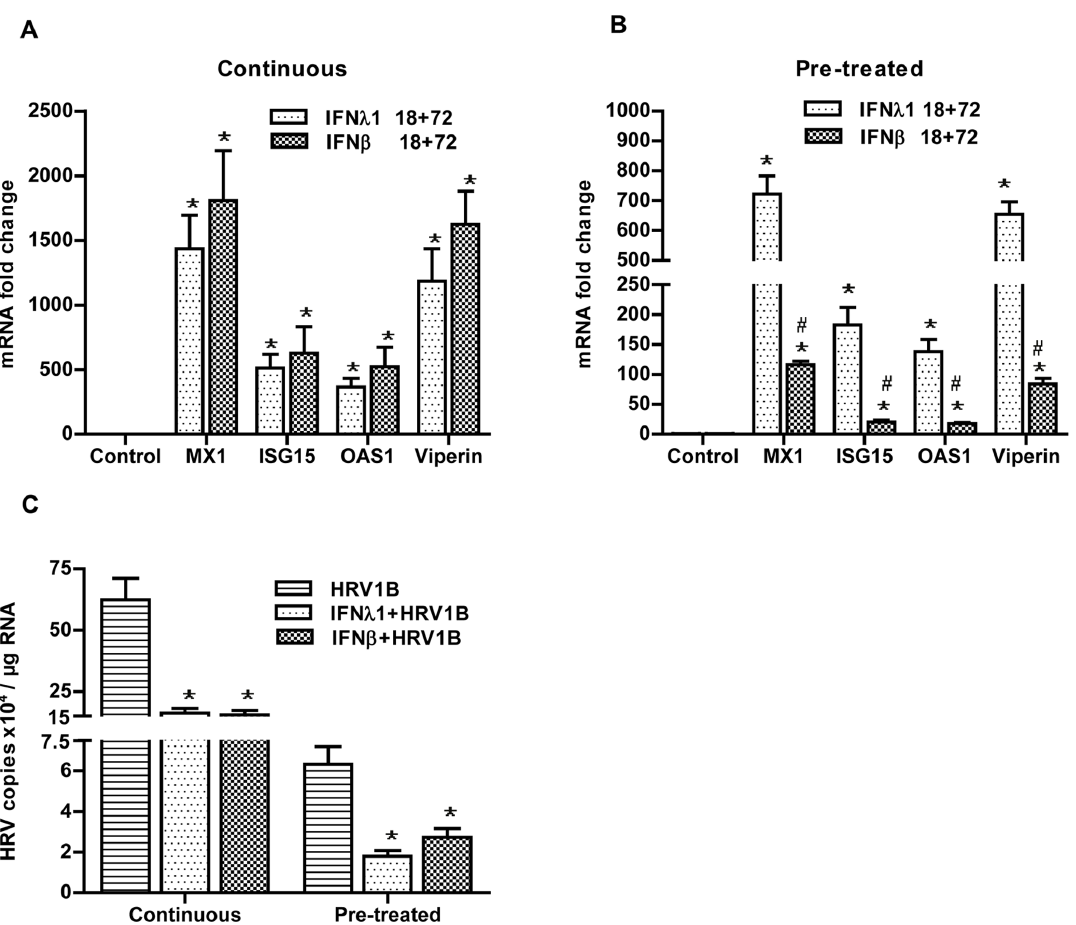
Figure 2. Long-lasting antiviral state induced by IFNs. A549 were treated with IFNs for 18 h. Next, according to the continuous and pre- treatment approaches, cells cultured for another 72 h and collected afterwards for further analyses (n=4). mRNA expression of different genes was determined by qPCR and fold changes were calculated with the 2 2 DD Ct method (A & B). Moreover, to evaluate the antiviral status of the cells after 72 h of culturing, cells were infected with HRV1B and incubated for another 24 h (n=5). After that, viral copies were determined by qPCR and fold changes were calculated with the 2 2 DD Ct method (C). *, p , 0.05 HRV1B vs IFNs + HRV1B, control vs IFNs. # , p , 0.05 IFN- l 1 vs IFN- b .